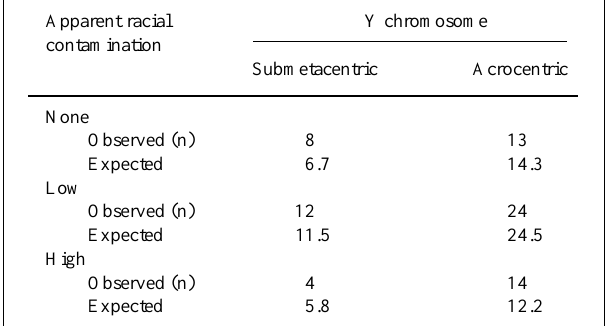
Table IV - Y chromosome type versus the degree of apparent racial contamination (see text).